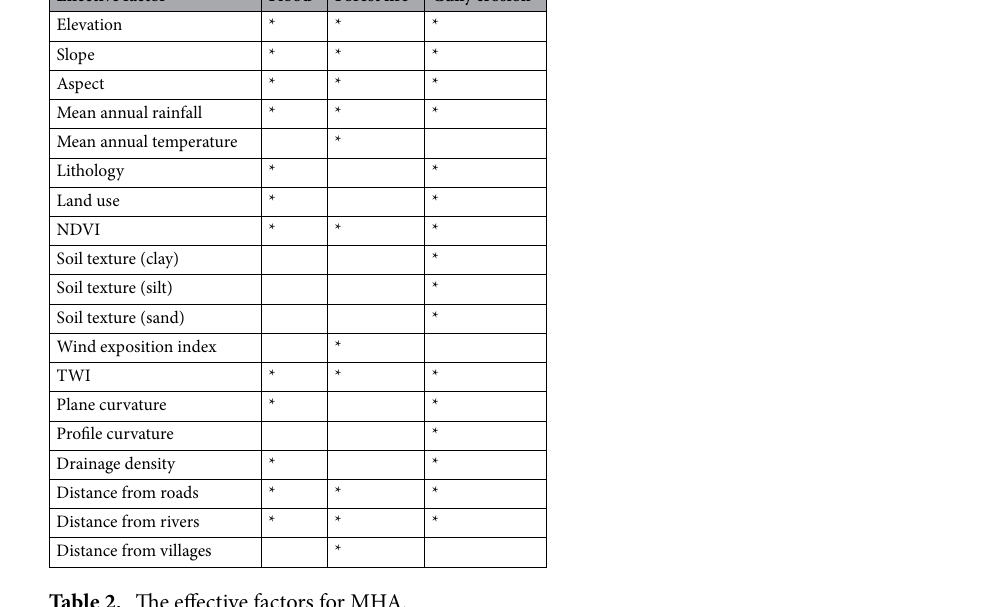
Table 2. The effective factors for